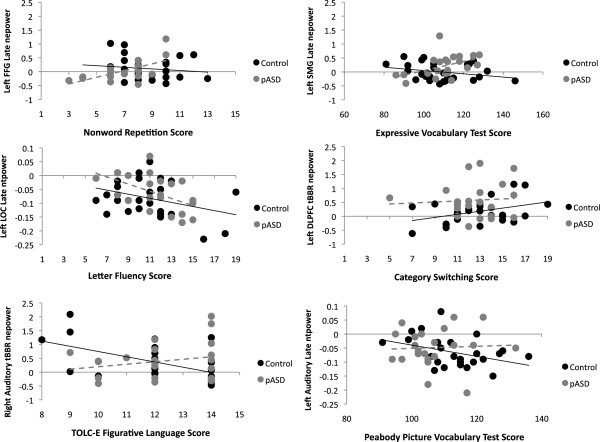
Beta regression results. Representative plots of the regression results assessing the relationships between beta-band activity and language measure scores. nepower: normalized evoked power; ntpower: normalized total power; tBBR: transient beta band response (30–150 ms post-stimulus), late: late beta band response (200–800 ms post-stimulus); DLPFC: dorsolateral prefrontal cortex; LOC: lateral occipital cortex; FFG: fusiform gyrus; TOLC-E: Test of Language Competence-Expanded Edition.